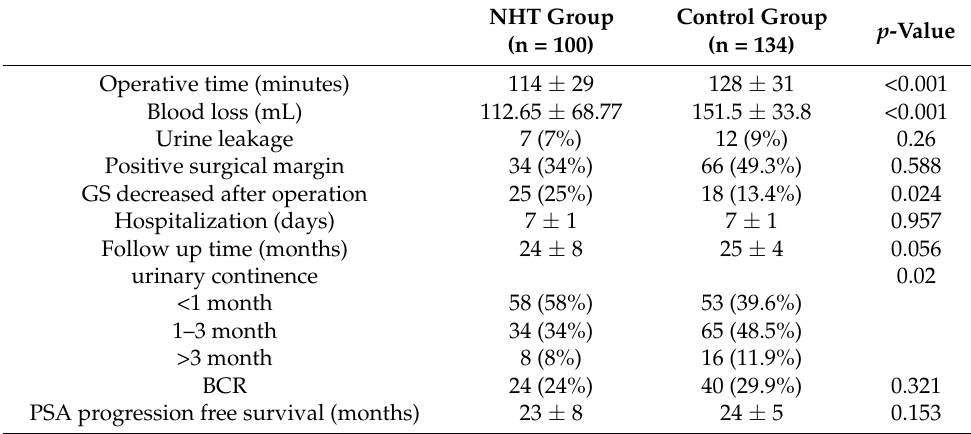
Table 3. Comparison of postoperative clinical characteristics between the NHT and control groups in the LRP